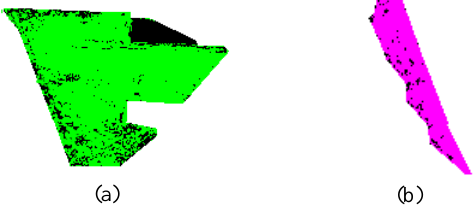
Figure 7. Result of ECRA (Black are invalid regions removed from training samples. Samples from other regions are used for learning in next iteration)